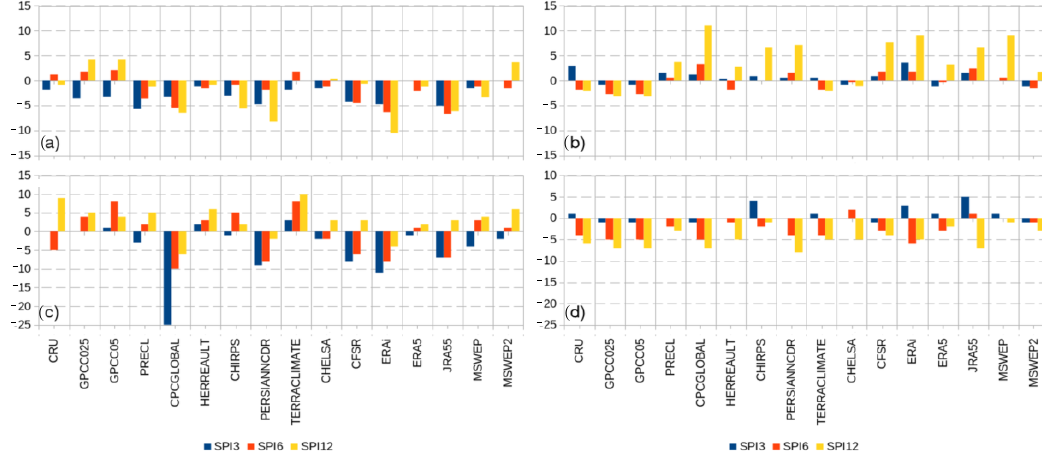
Figure 7. Di ff erences between observation and the GPP for drought statistics derived from SPI-0.5 (left column) and SPI-1.5 (right column). Drought Frequency (DF) and Number of Drought Events (DE) are shown in panels ( a , b ), and ( c , d ), respectively. Bars show values for SPI3 (blue), SPI6 (red) and SPI12 (yellow). In the case of DF ( a , b ) the di ff erences are represented as percentage.